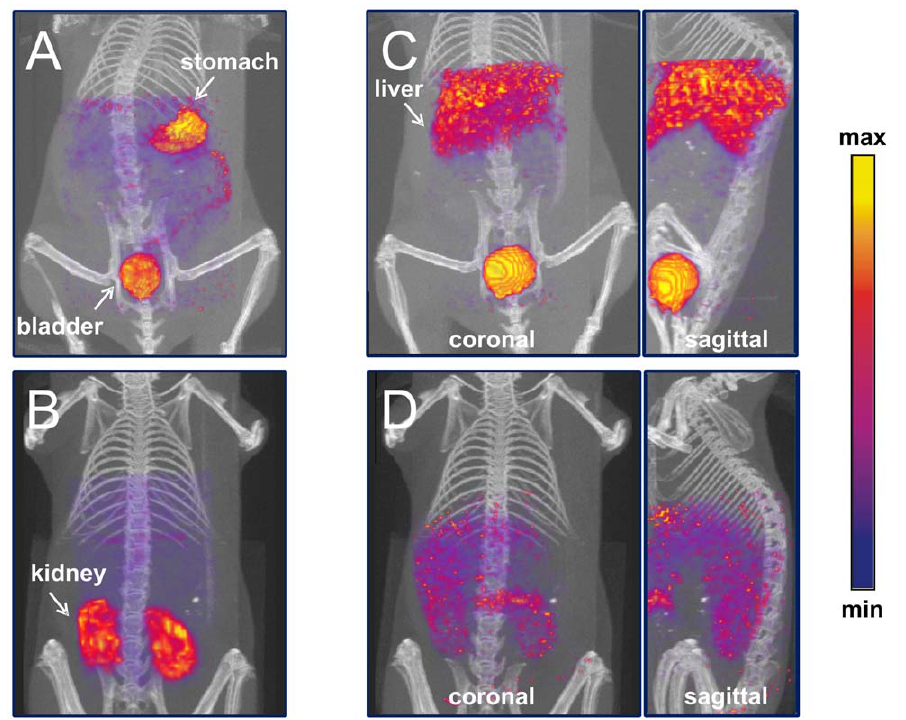
Figure 7. SPECT imaging analysis of a mouse injected with an adenovirus containing a capsid-incorporated pIX-MT fusion protein. C57BL6 mice were injected intravenously with approximately 1 mCi of 99m Tc in 0.3 mL PBS, and scanned at 30 min after the injection. Afterwards, 3D renderings of SPECT images in blue-purple-red-yellow scale against CT projections in grey scale were obtained. Shown are: (A) coronal image of a normal mouse injected with 99m Tc-pertechnetate; (B) coronal image of a mouse injected with 99m Tc-glucoheptonate; (C) coronal and sagittal images of a normal mouse injected with 99m Tc-Ad-tGFP-pIX-MT; and (D) coronal and sagittal images of a mouse pretreated with warfarin injected with 99m Tc- Ad-tGFP-pIX-MT.